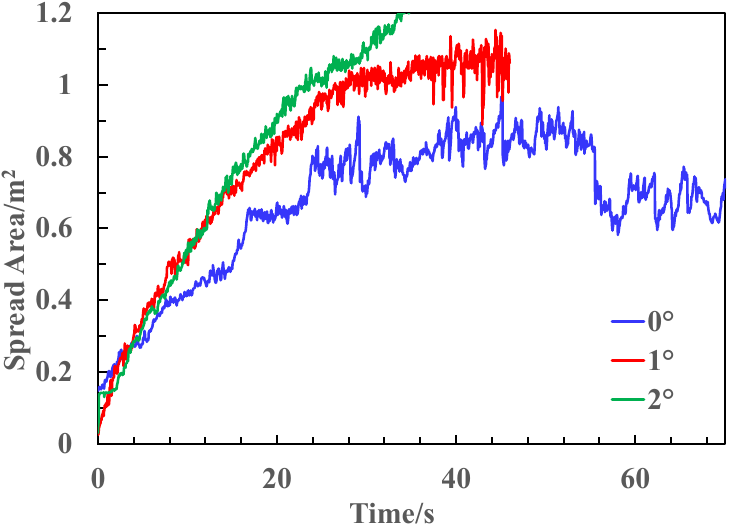
Figure 5. Spread area over time for the same discharge rate in an n-heptane spill fire.